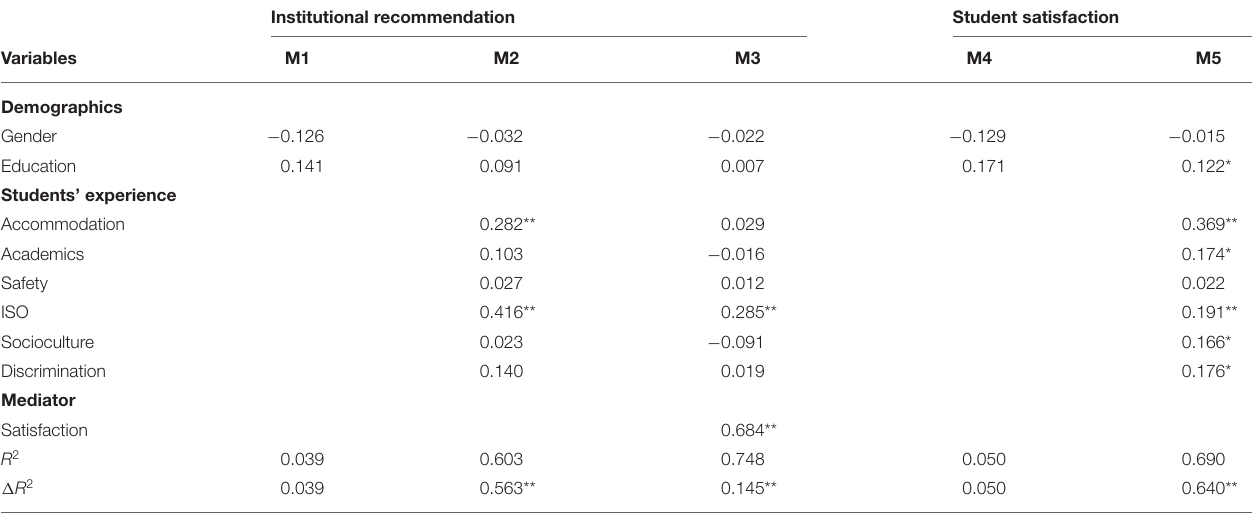
TABLE 5 | Results of Asian students.